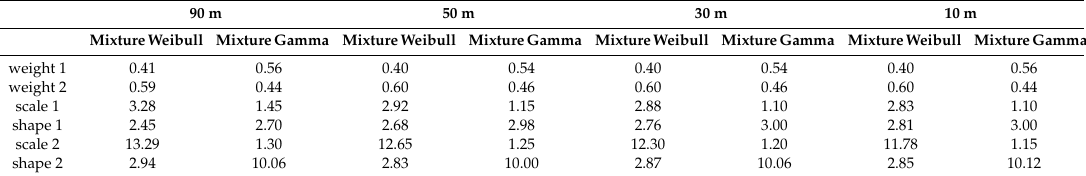
Figure 8. Fitted density functions of the mixture gamma, mixture Weibull, and univariate Weibull (maximum likelihood method) distributions for wind speed data at different heights. ( a ) 90 m, ( b ) 50 m, ( c ) 30 m, ( d ) 10 m. Table 2. Parameters of the fitted mixture Weibull and mixture gamma distributions for the wind speed data at different heights. 90 m 50 m 30 m 10